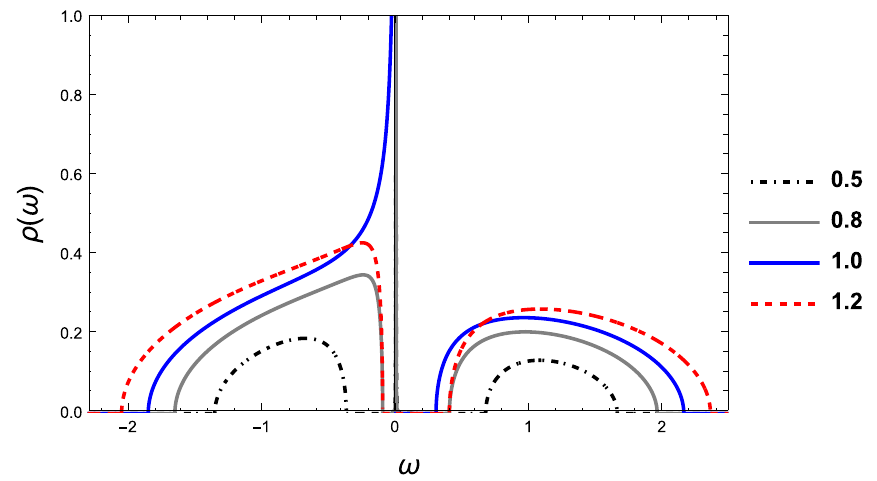
Figure 10. Density of states corresponding to different values of V 1 / V 2 = 1.2 ; 1.0 ; 0.8 ; 0.5 . The legends represent the values of ˜ V = V 1 / V 2